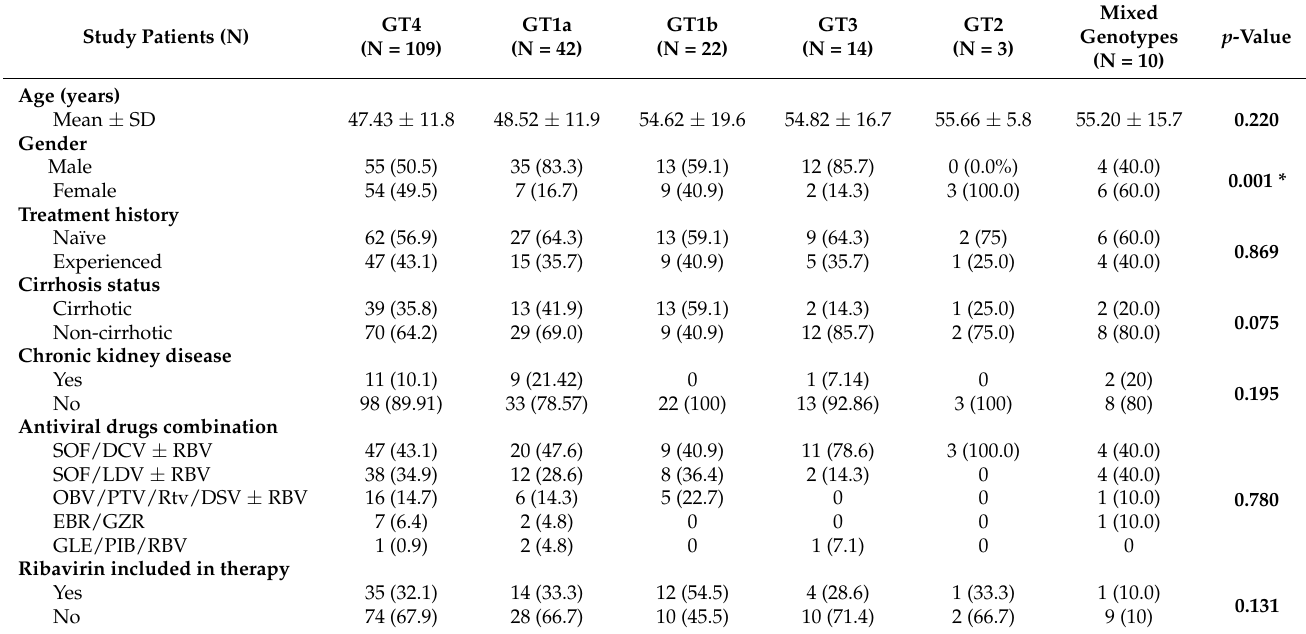
Table 2. The study patients were stratified by the infecting HCV genotype (baseline characteristics of the study patients and prescribed antiviral drugs based on the infecting HCV